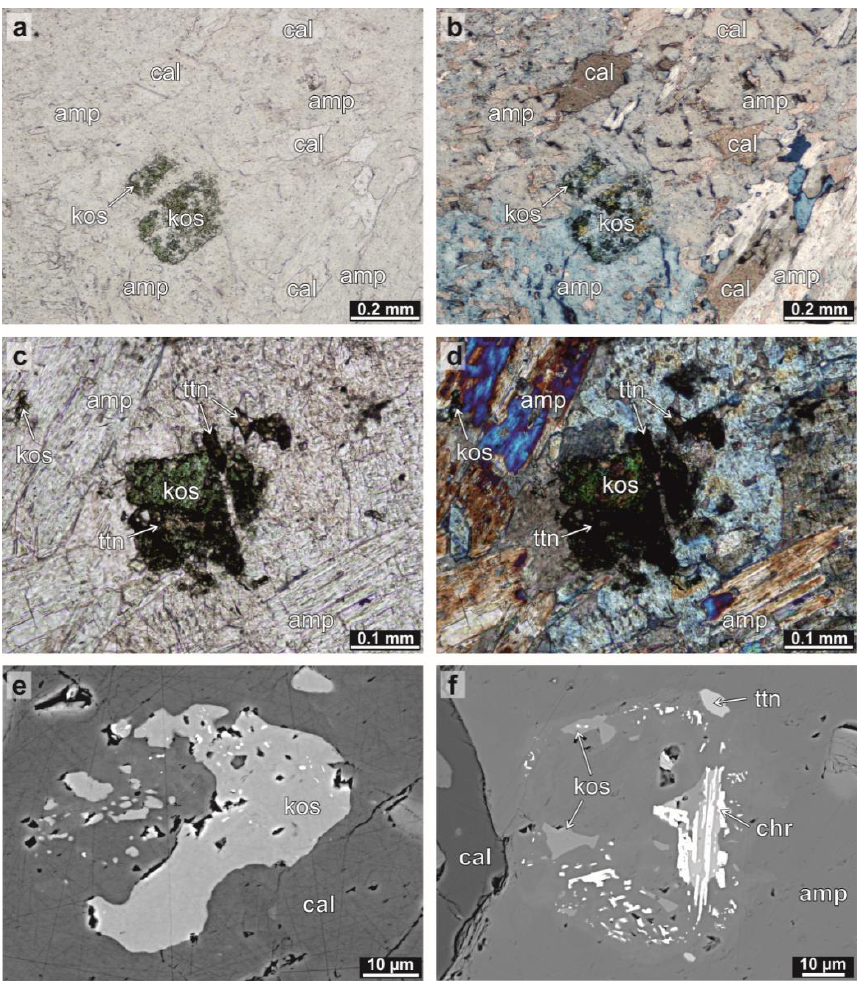
Figure 3. Microphotographs of Na–Cr-rich pyroxene in the investigated samples. Pictures on the left and right side are in plane-polarized and cross-polarized light, respectively. ( a , b ) Na–Cr-rich pyroxene grain from sample IC03D with amphibole and calcite. ( c , d ) Na–Cr-rich pyroxene grain from sample IC03E with associated titanite; ( e ) large Na–Cr-rich pyroxene grain from sample IC03B; ( f ) skeletal and partly decomposed grains of chromite with minor Na–Cr-rich pyroxene and titanite surrounded by amphibole in sample IC04A. For simplicity, Na–Cr-rich pyroxene is abbreviated ‘kos’ in this figure while we refer to the main text for further details on the chemistry of this phase.